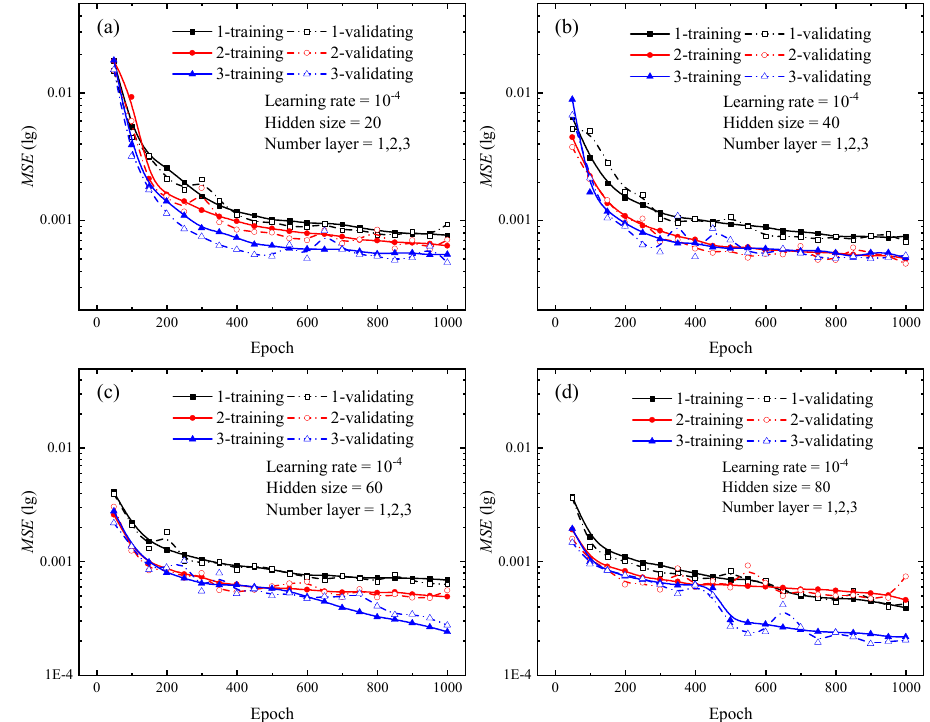
Figure 4. Loss curves of different numbers of hidden layers during the training and validating phrases for indentation predictions. ( a ) Hidden size of 20; ( b ) Hidden size of 40; ( c ) Hidden size of 60; ( d ) Hidden size of 80. In the legend, the cases of 1, 2, and 3 represent the number of hidden layers in the LSTM neural